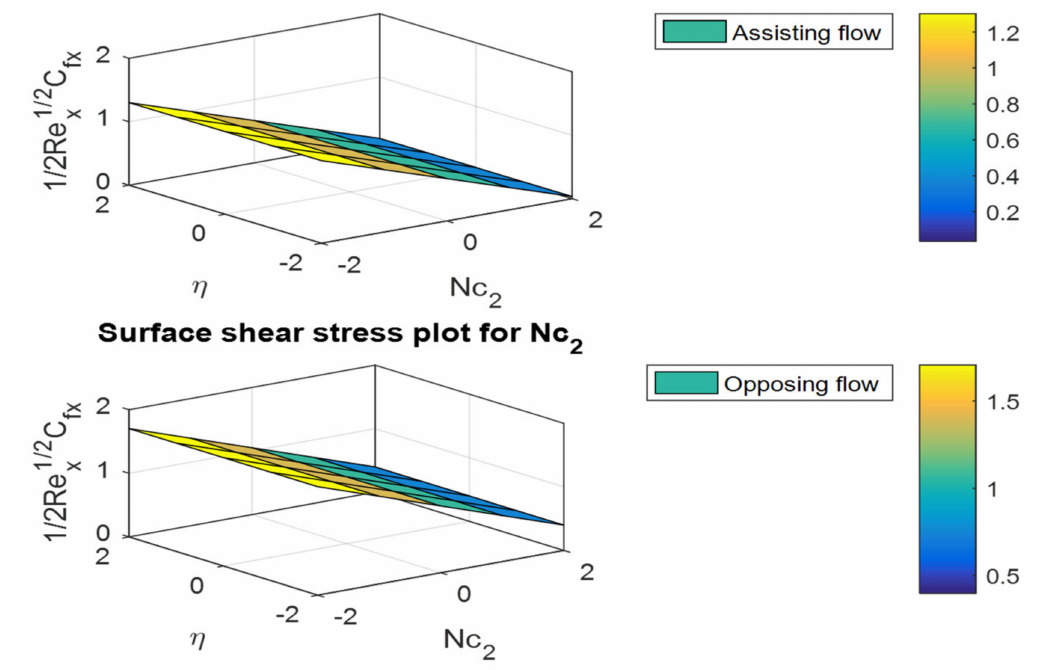
Figure 34. Surface plots for the f (cid:48)(cid:48) ( 0 ) for dissimilar values of Nc 2 .